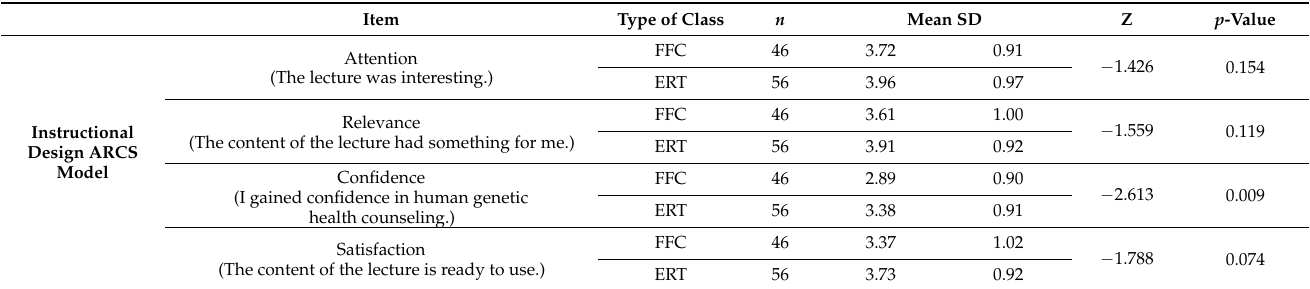
Table 5. Course design evaluation by class